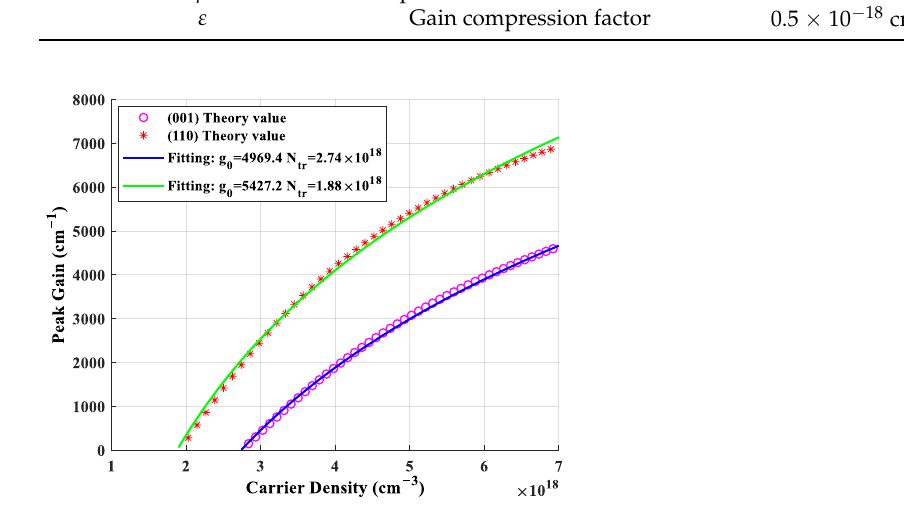
Figure 8. Schematic cross-section of InGaAs 850 nm VCSEL structure .